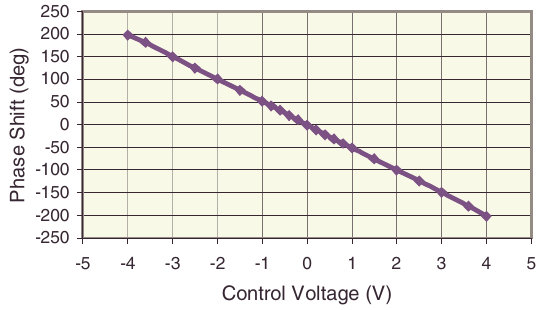
FIG. 7. (Color) Phase shifter’s control curve. Phase slope is 50 (cid:1) = V .